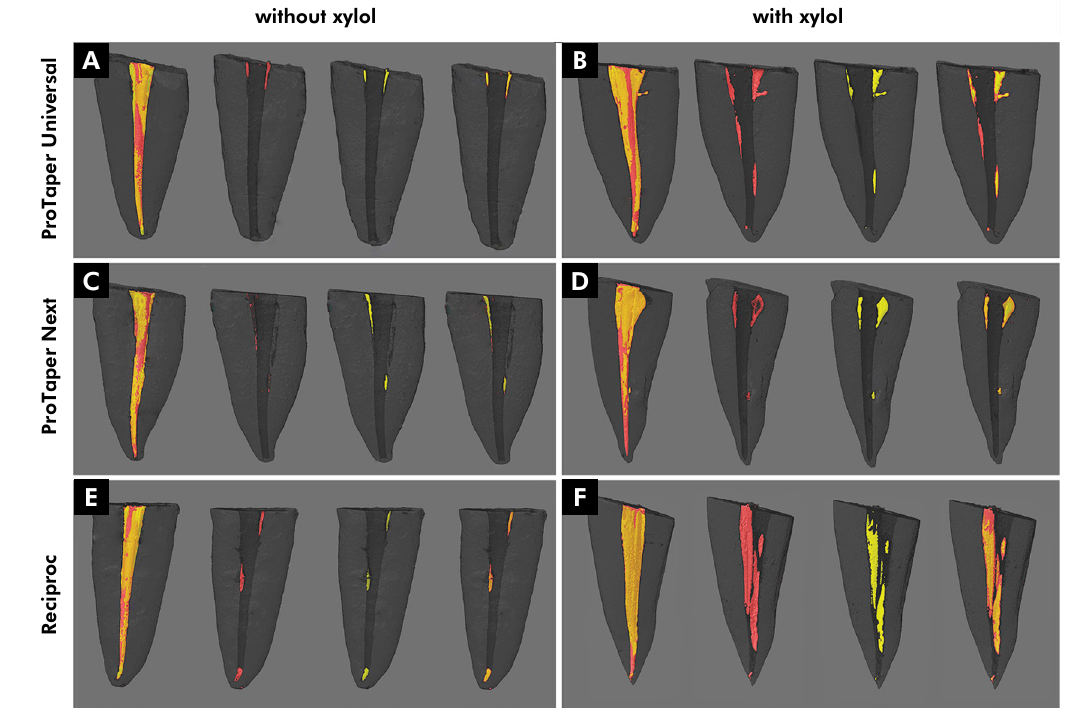
Figure. Three-dimensional illustrative images of the experimental groups. Sequence from left to right shows: filled specimen, remnant of gutta-percha, remnant of sealer and the overlap of the remnant of gutta-percha and